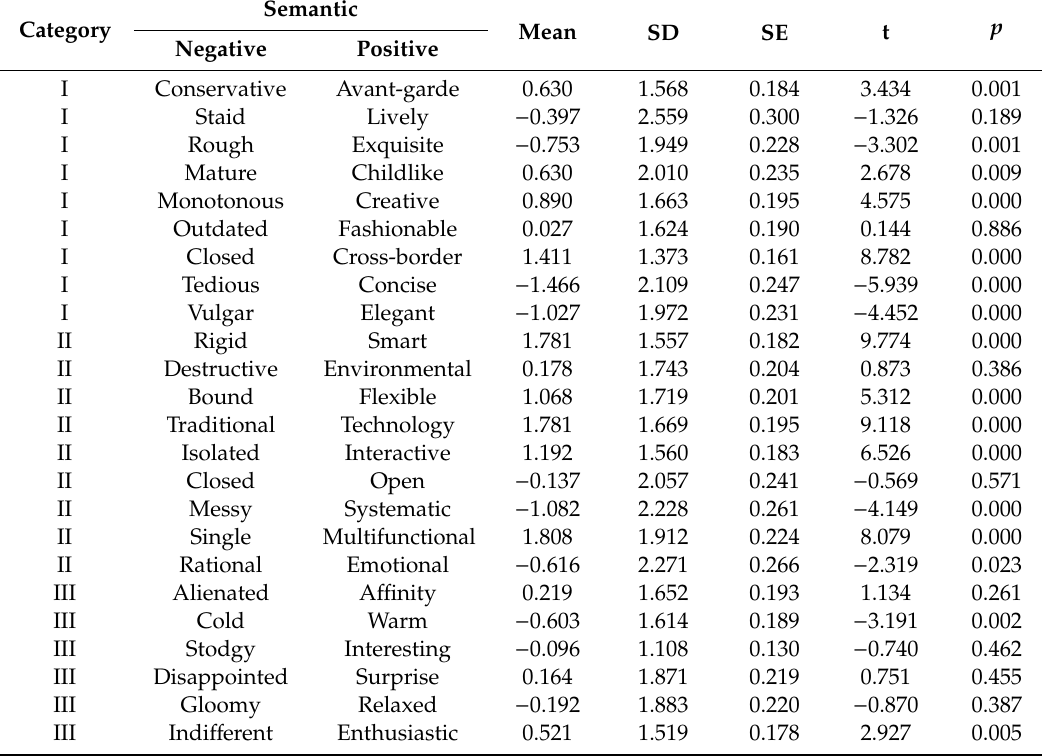
Table 2. Semantic opposite adjective pairs and results of the paired-samples